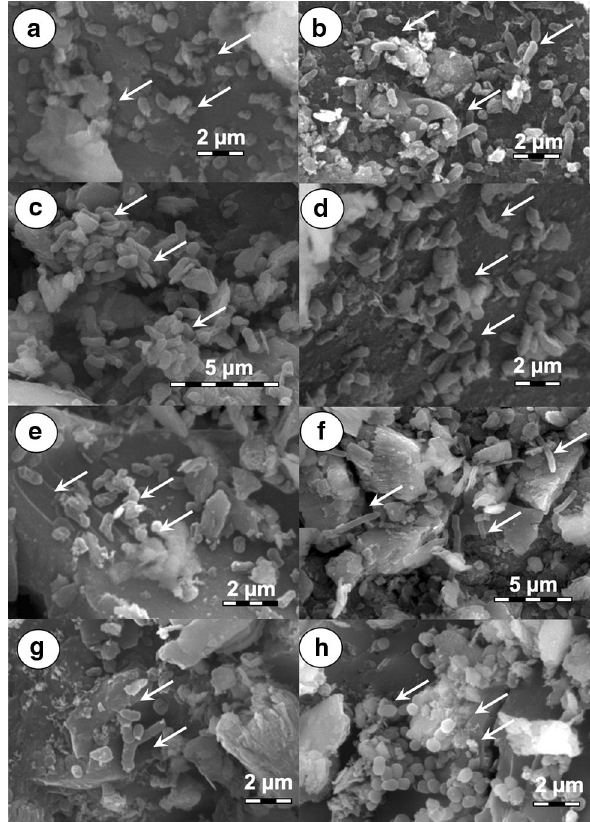
Fig. 3 Scanning electron micrographs showing colonization by cells of Citrobacter strain ECCN 19b ( a , b ), Exiguobacterium strain ECCN 21b ( c , d ), Serratia strain ECCN 24b ( e , f ), and a consortium (ECCN 14b) of all three isolates ( g , h ) of either coal discard ( a , c , and e ) or geologically weathered coal ( b , d , and f ). Substrate colonization was facilitated in minimal salt medium and particles of either coal discard or geologically weathered coal were recovered after 7 d at 37 (cid:3) C. Arrows indicate bacterial colonization of and attachment to the coal